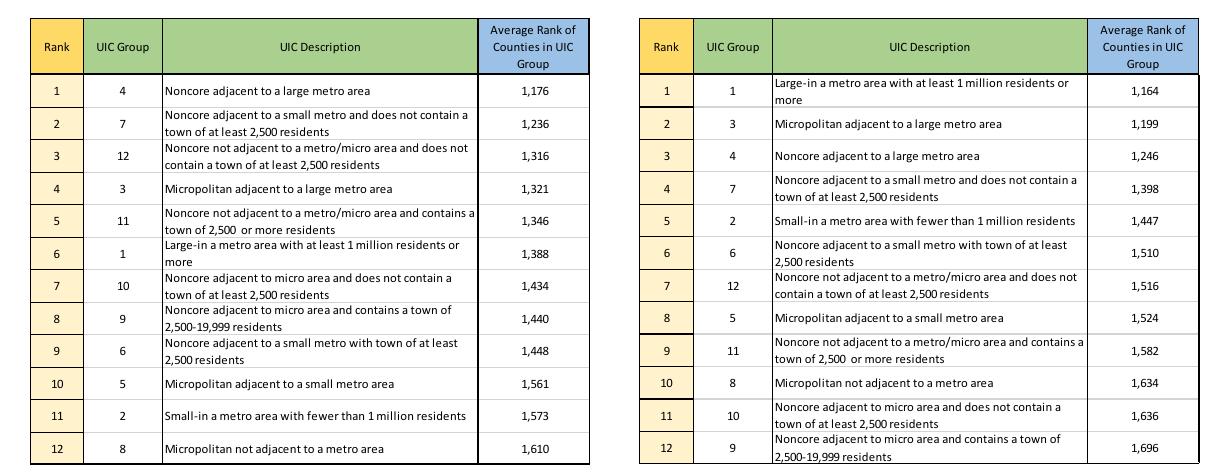
Table 15. UIC Group Ranking, 2007 Table 16. UIC Group Ranking,